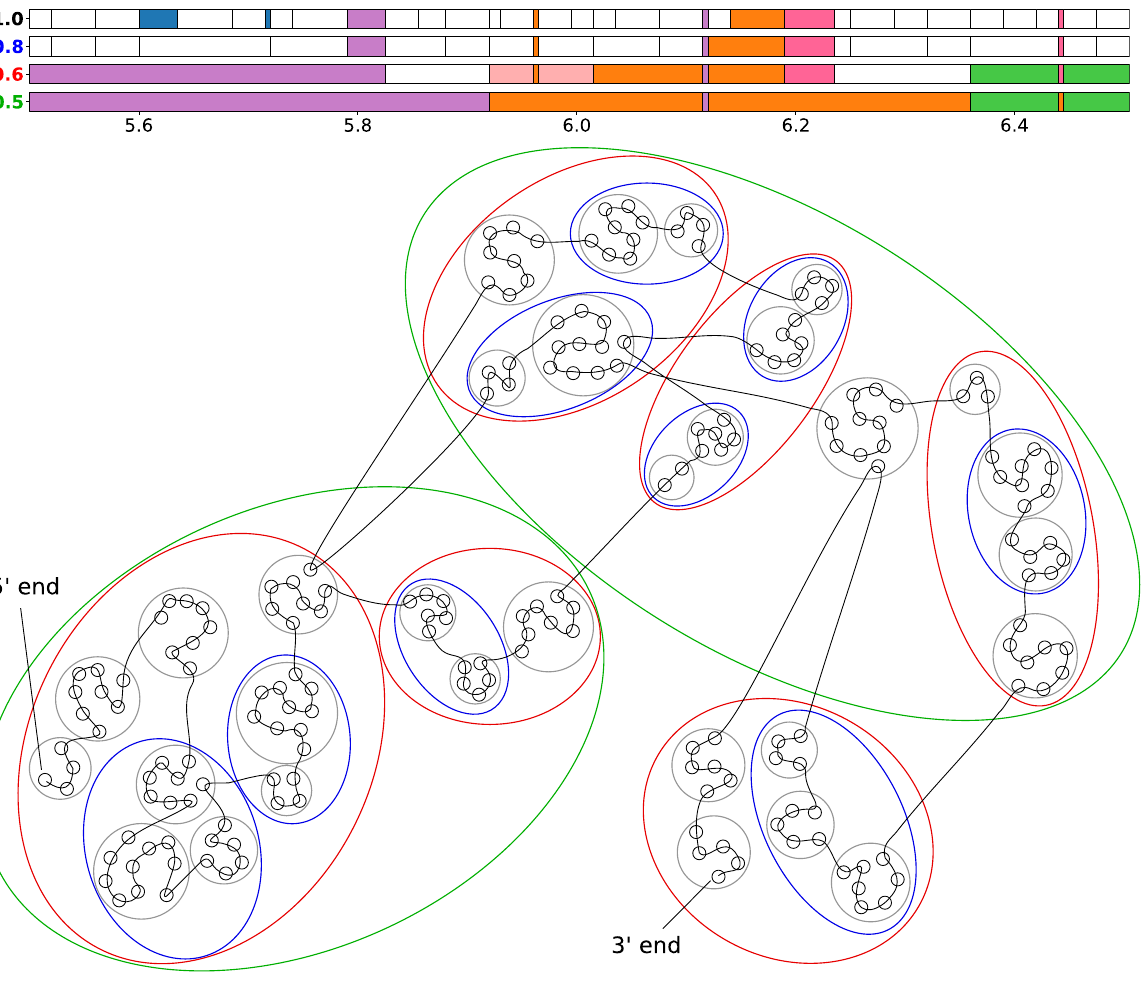
F i F j . The interaction energy is measured in number of contacts detected in Hi-C experiment between corresponding structural units. The procedure begins by considering each 5 kb bin as a separate structural unit, and iteratively merges pairs of structural units with the highest value of r ij . The global maximum value of r ij , denoted r max , decreases mono- tonically with each iteration, and at lowest r max = 1.0 the structural units of first level of hierarchy are obtained. Continuing with the iterative procedure reduces r max , yielding larger structural units that are more physically separated at lowest r max = [0.8, 1 ) , [ 0.6, 0.8 ) , and [0.5, 0.6), revealing the hierarchical organization of chromatin structure. The result of applying the procedure on a 1 Mb region is represented schematically in Fig. 3 (see also Supplementary Figure S6), where the top shows 1D representations of the structural units at different levels, and the bottom shows how individual 5 kb bins (black nodes) are grouped into structural units at different levels of hierarchy (grey, blue, red, and green ellipses). Supplementary Table S2 lists the average unit size at lowest